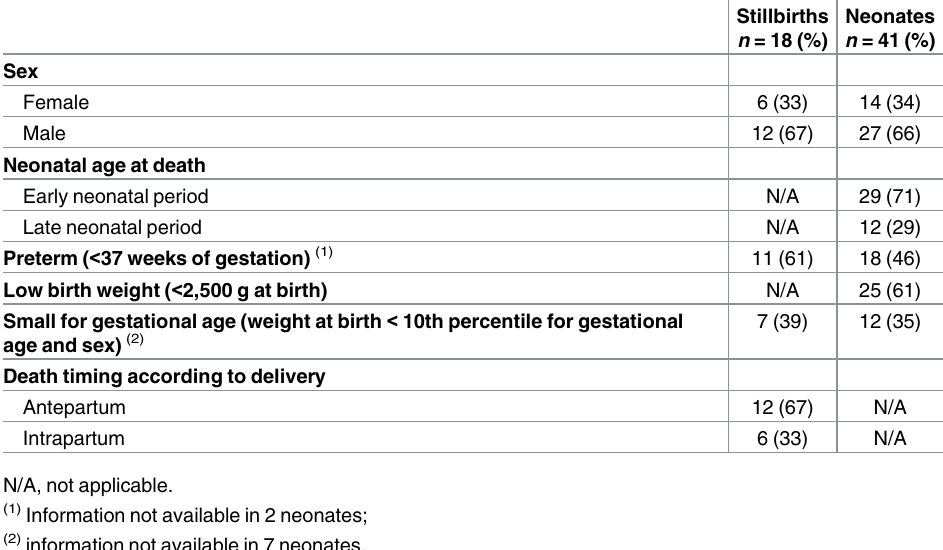
Table 1. Characteristics of stillbirths and neonatal deaths.